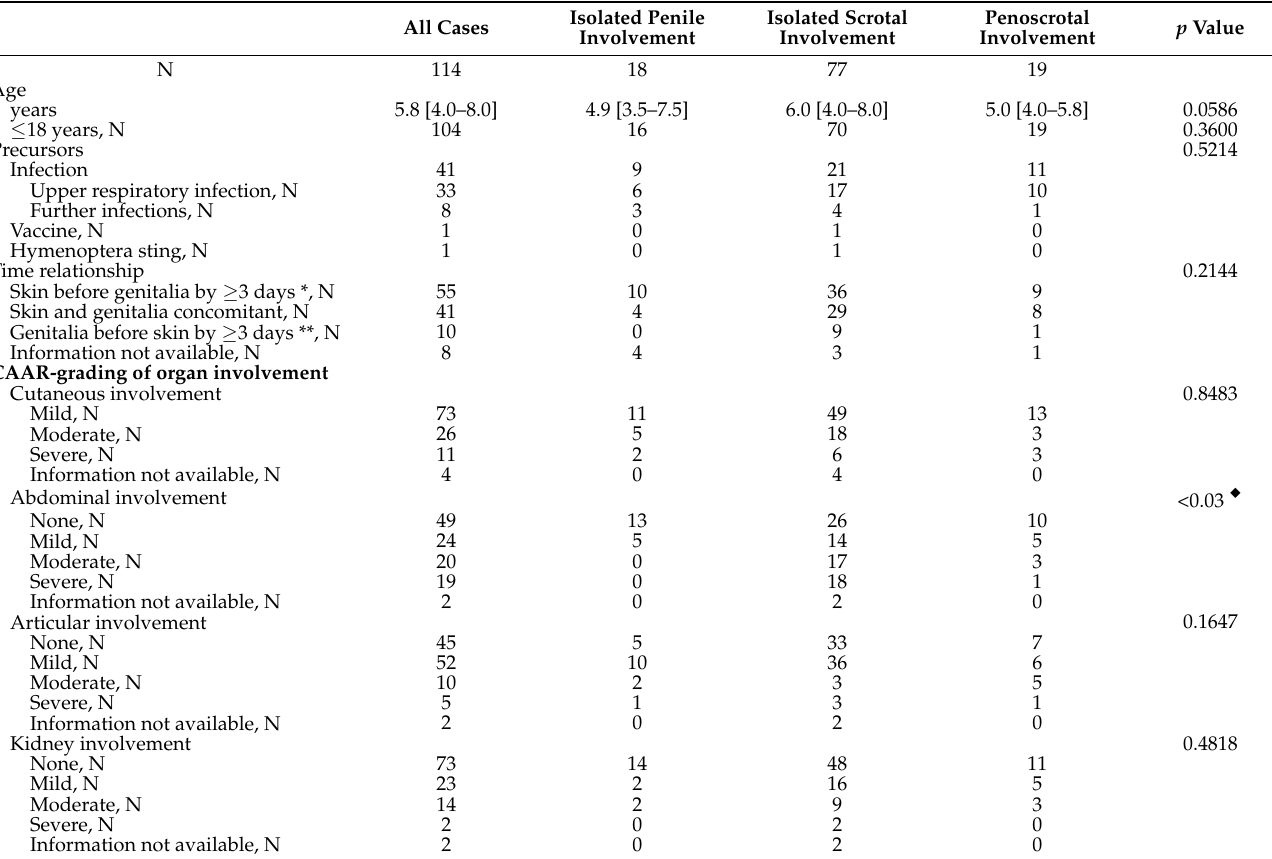
Table 2. Involvement of male external genitalia in Henoch–Schönlein syndrome. Characteristics of the 114 cases (1.5 to 75 years of age).